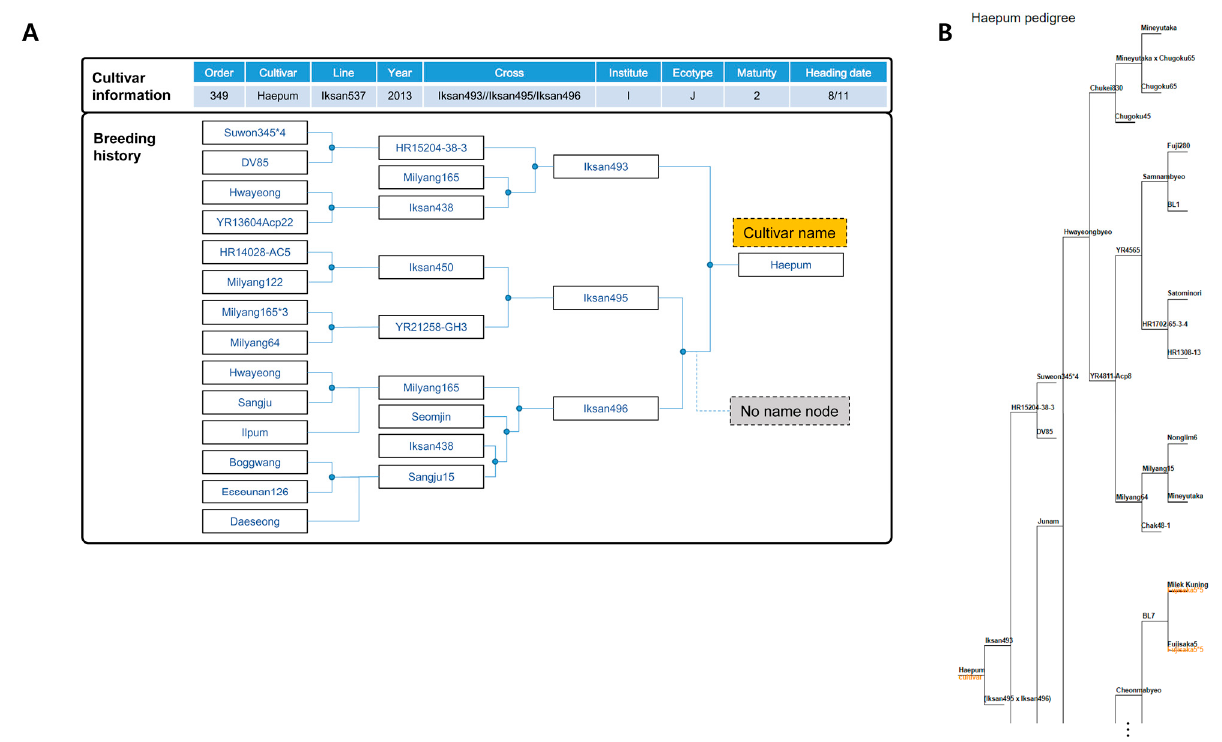
Figure 1 . Documentation of cultivar “Haepum” ( A ) Image-based documentation from RDA; the words in the boxes are the translation of Korean into English. The yellow boxes show the registered cultivar names. The gray box indicates the example node without an explicit name or ID. ( B ) Hier- archical tree of “Haepum” from the RicePedigree database .